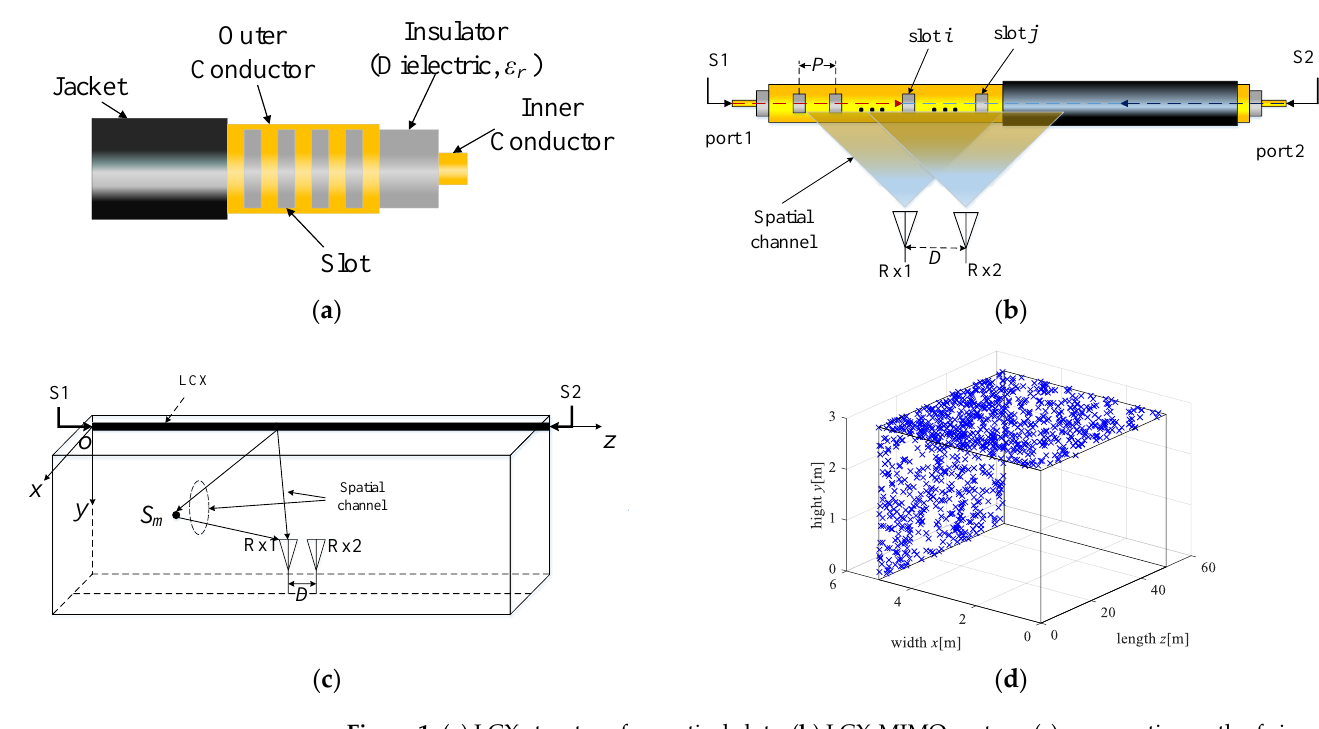
Figure 1. ( a ) LCX structure for vertical slots; ( b ) LCX-MIMO system; ( c ) propagation path of signal for LCX ‒ MIMO system; ( d ) the distribution of effective scatterer in tunnel, “ × ” denotes the scatterer in the side wall or the roof of the tunnel. Table 1. Parameters for LCX ‒ MIMO system.